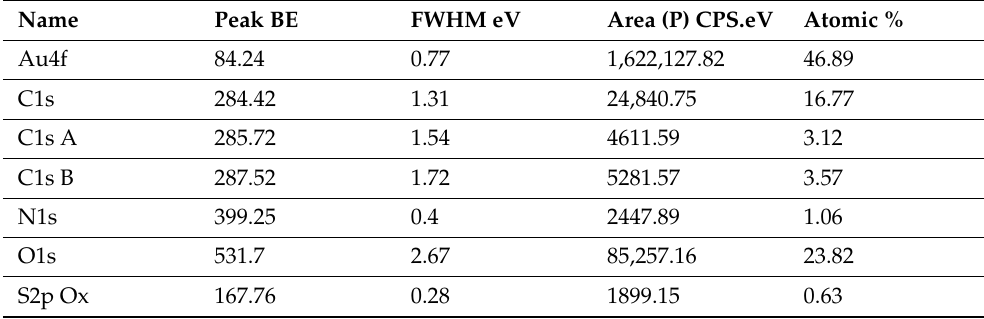
Table A1. Characteristics of the XPS peaks, attribution and atomic percentage for a bare Au